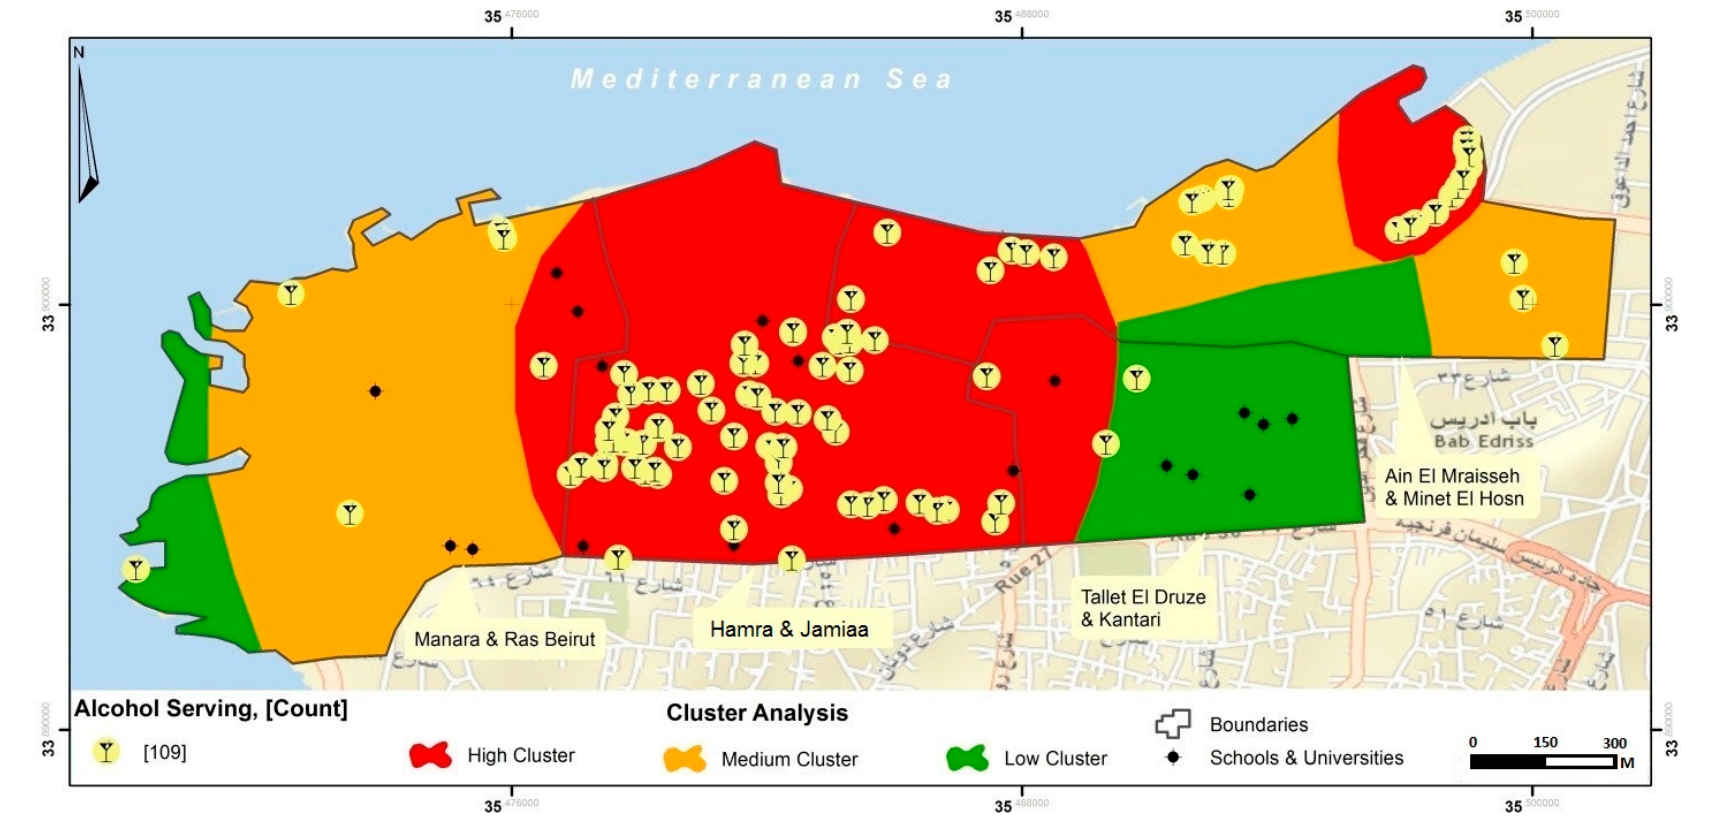
Figure 2. Raster analysis showing spatial distribution of alcohol outlets.